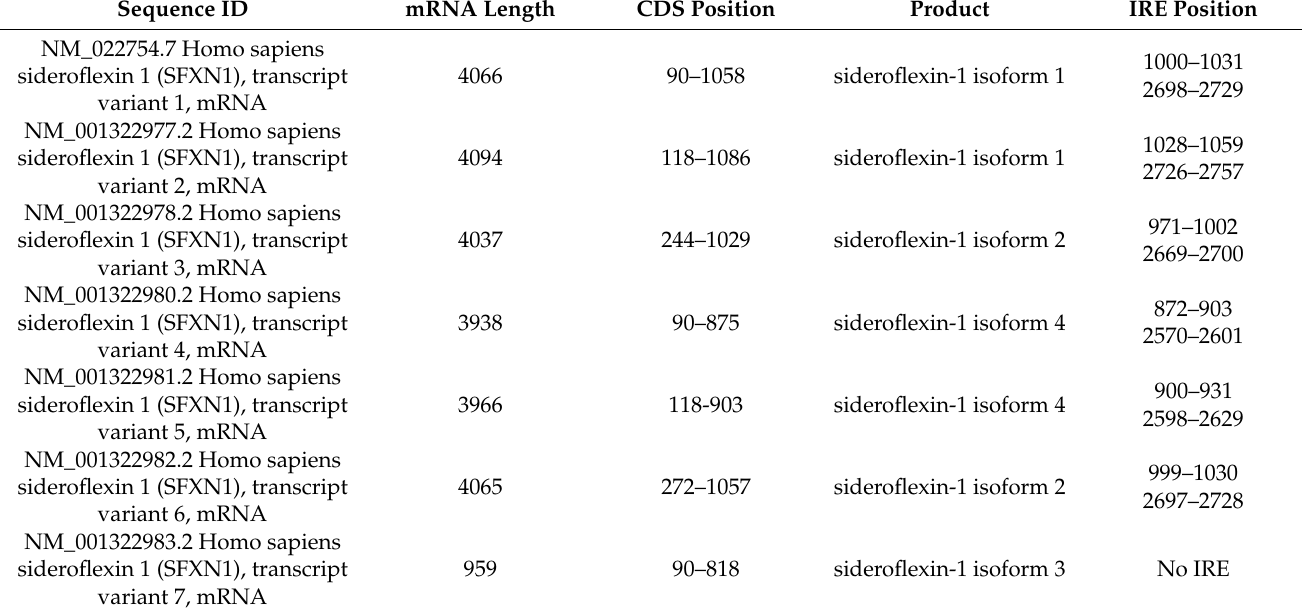
Table 4. Location of predicted IRE in SFXN1 splicing